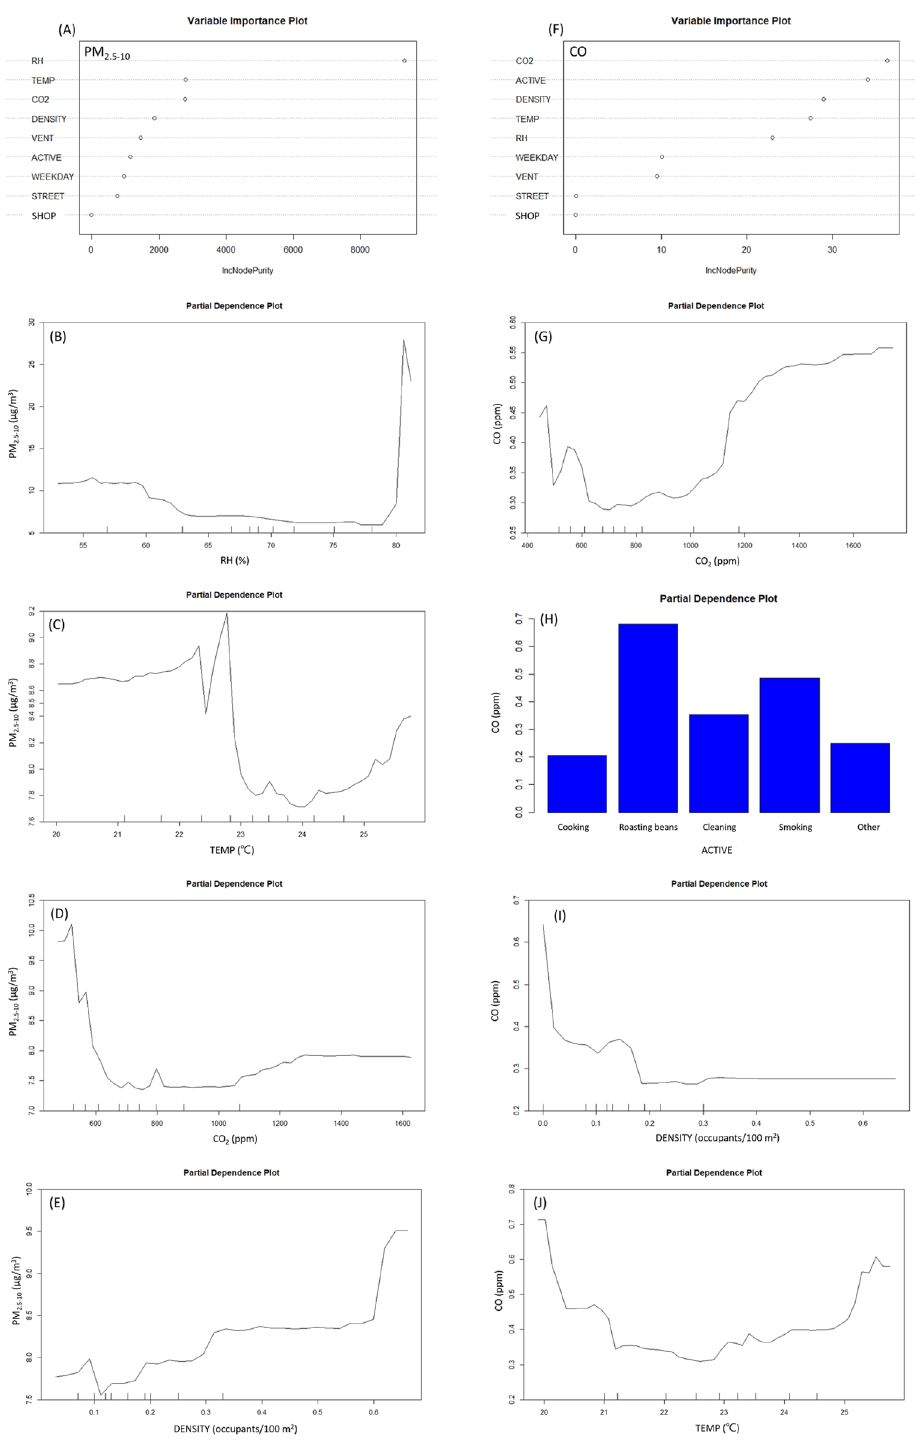
Figure 3. Variable importance rank and partial dependence plot of PM 2.5–10 and carbon monoxide (CO) from Random Forests models. (PM 2.5–10 , particulate matter with an aerodynamic diameter between 2.5 and < 10 μm (μg/m 3 ); ACTIVE, Indoor activities; CO 2 , carbon dioxide(ppm); DENSITY, Occupant density (person/m 2 ); RH, relative humidity (%); SHOP, coffee shop A, B, C, D; STREET, locating on the main traffic street; TEMP, temperature(°C); VENT, ventilation